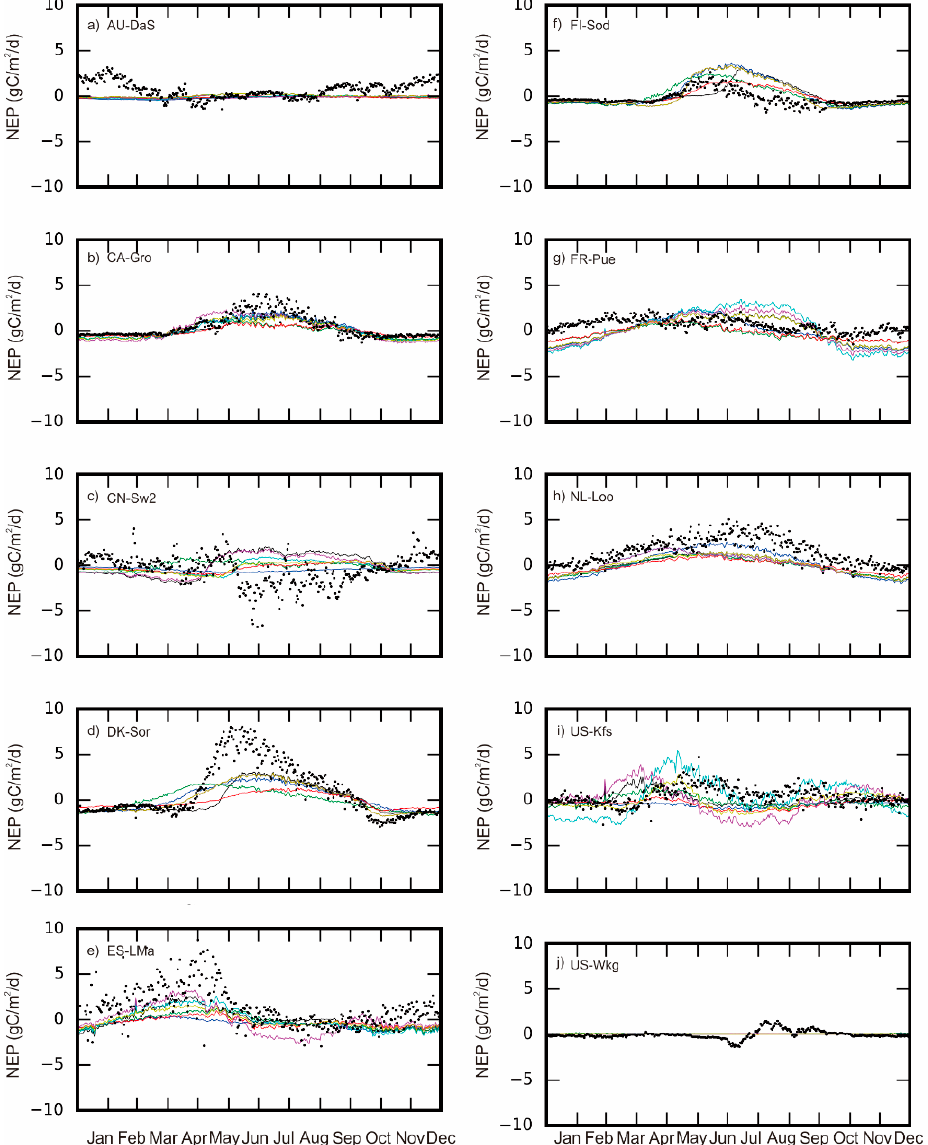
Figure A1. Multi-year mean of simulated daily net ecosystem productivity (NEP) and observed data (dot) from FLUXNET. ( a – j ) corresponds to 10 sites listed in Table 6. The black line denotes simulation with prior parameter values, the blue line denotes multi-site assimilation result with soil moisture and FAPAR, the green line denotes multi-site assimilation result with soil moisture, the red line denotes multi-site assimilation result with FAPAR, the cyan line denotes single-site assimilation result with soil moisture and FAPAR from each site grid, the magenta line denotes single-site assimilation result with soil moisture from each site grid, and the dark yellow line denotes single-site assimilation results with FAPAR from each site